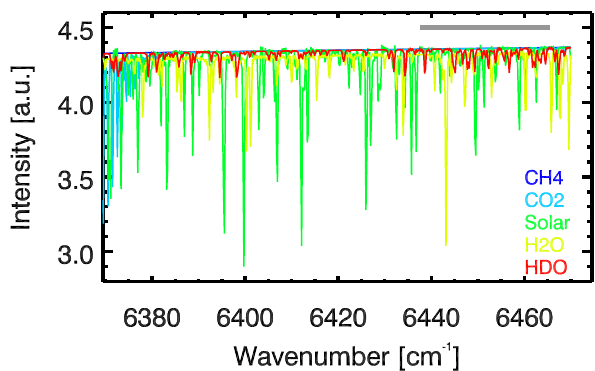
Fig. 2. As Fig. 1 but for a small spectral range. The grey bar indi- Fig. 2. As Figure 1 but for a small spectral range. The grey bar cates the fit window used for the HDO/H 2 O indicates the fit window used for the HDO/H 2 O retrieval.